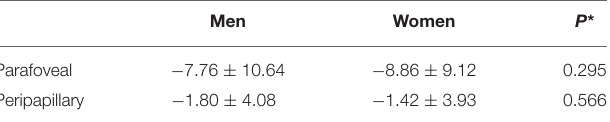
Frontiers in Physiology |